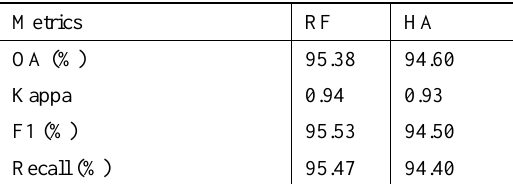
Table 3. Accuracy Metrics for Evaluating Results